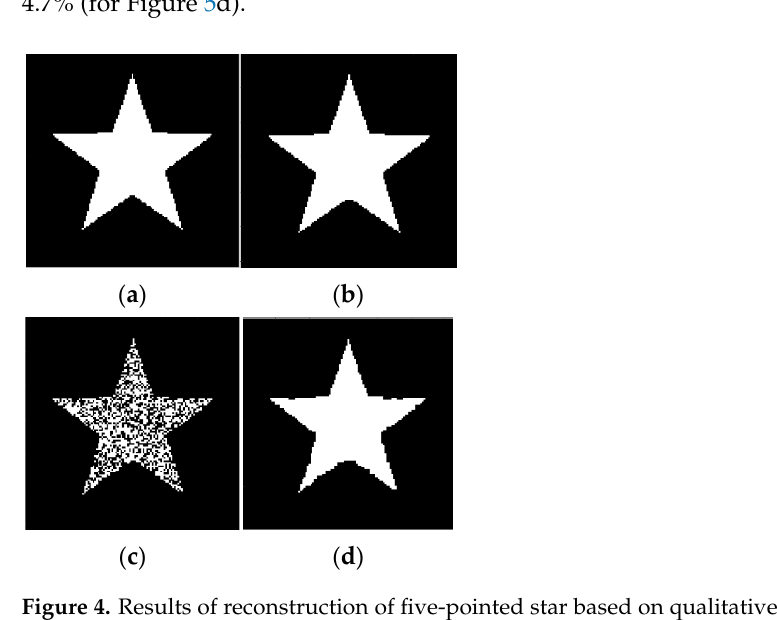
Figure 4. Results of reconstruction of five-pointed star based on qualitative data. ( a ) Original star; ( b ) Reconstructed star; ( c ) Original strong noisy star; ( d ) Reconstructed noisy star.